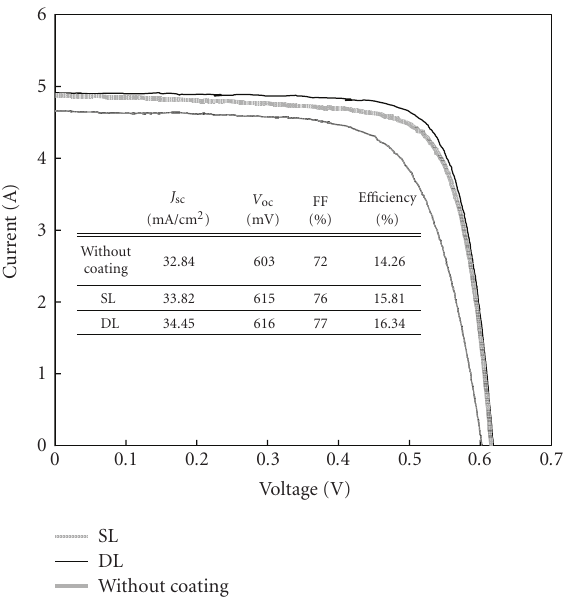
Figure 5: Comparison of IV-curves of a 125 × 125mm 2 of the di ff erent results from DL, SL, and without coating. DL’s conversion e ffi ciency is the